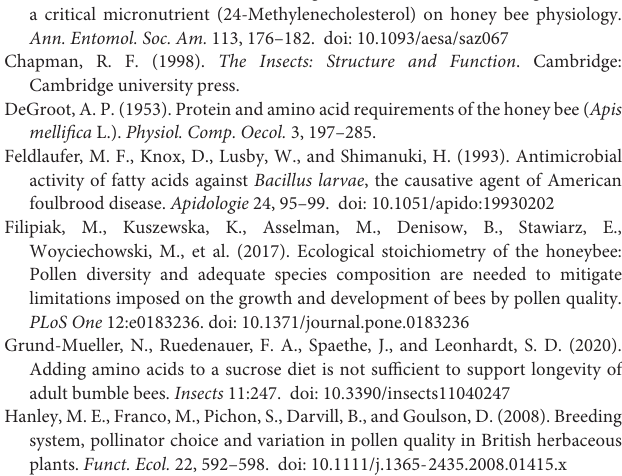
Supplementary Table 1 | Mean concentrations as naturally found in pollen and stimulus concentrations of amino acids (AA). Supplementary Table 2 | Mean concentrations as naturally found in pollen and stimulus concentrations of fatty acids (FA). Supplementary Table 3 | Mean concentrations as naturally found in pollen and stimulus concentrations of sterols (S). Supplementary Table 4 | Statistical results of the generalized additive mixed effect models (GAMMs) testing for differences in learning performance between different